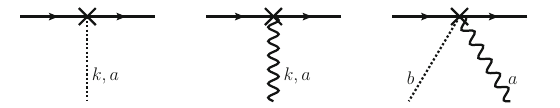
Fig. 3 Feynman rules for an E i ( t ) operator insertion (denoted by a cross in the diagram) on a static quark (Wilson) line. Dotted and wavy lines represent A 0 and A gluons, respectively. All momenta ( k , l , q , p ) are incoming. Note that, in contrast to the usual convention for Wilson lines, we treat the antiquark (lower Wilson line) as a particle living in the anti-representation of SU ( 3 ) , i.e. the fermion flow (little arrows) of the antiquark is the same as for the quark. The corresponding Feynman rules for the antiquark are then obtained by replacing g → − g and T a → ( T a )